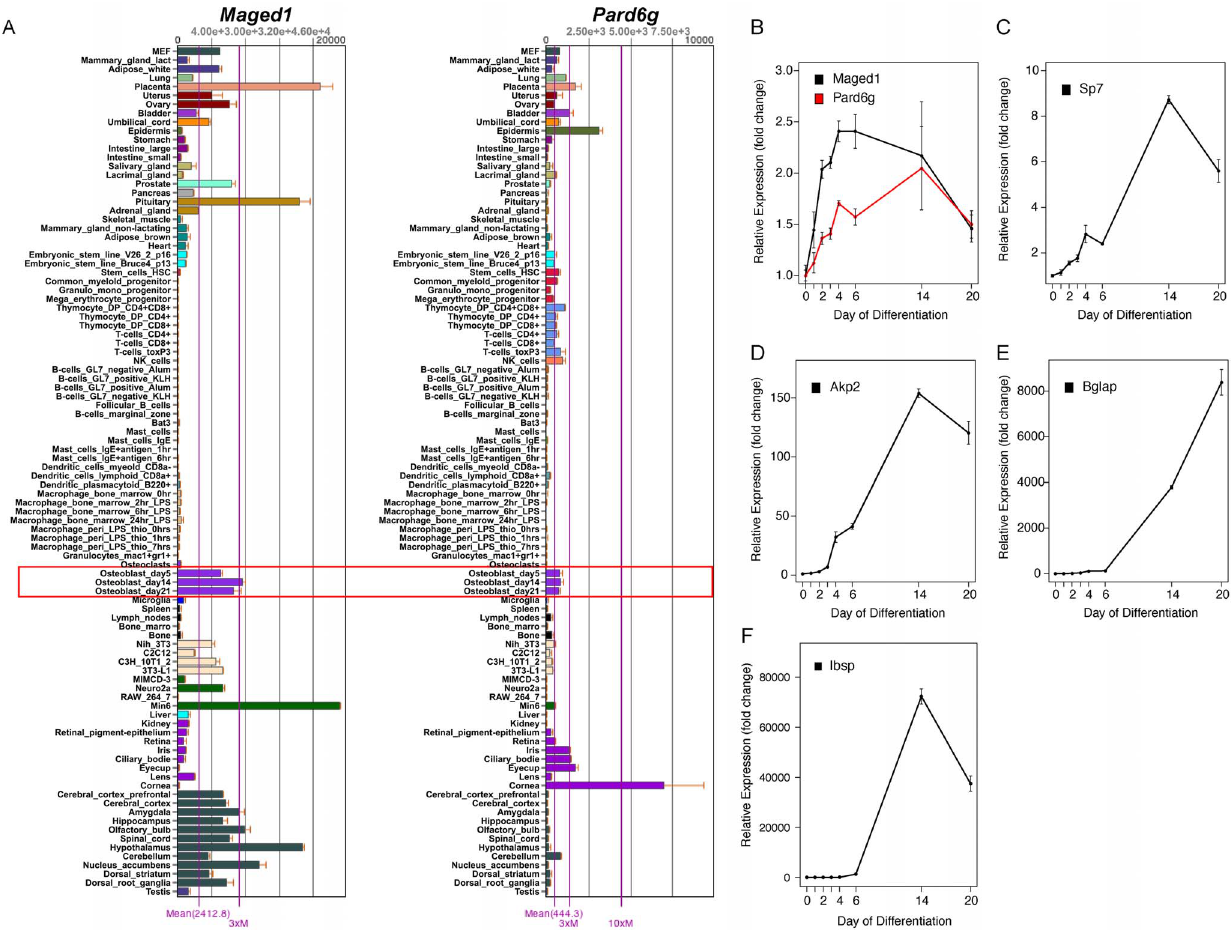
Figure 3. Maged1 and Pard6g are expressed in osteoblasts. (A) Maged1 and Pard6g are expressed in multiple mouse tissues and cell-lines including primary calvarial osteoblasts (outlined in red). The data are from a microarray experiment of tissues and cell lines (tissues and primary cell lines from C57BL6/J mice) and are the mean 6 SEM of three biological replicates [29]. Images were downloaded and modified from BioGPS (http:// biogps.org/) [65]. The expression of (B) Maged and Pard6g, (C) Sp7, (D) Akp2 , (E) Bglap and (F) Ibsp expression as a function of differentiation in primary calvarial osteoblasts (P=0.03 for Maged1 and Pard6g and P , 0.001 for all other genes). The data represent mean 6 SEM (N=4 at each timepoint).